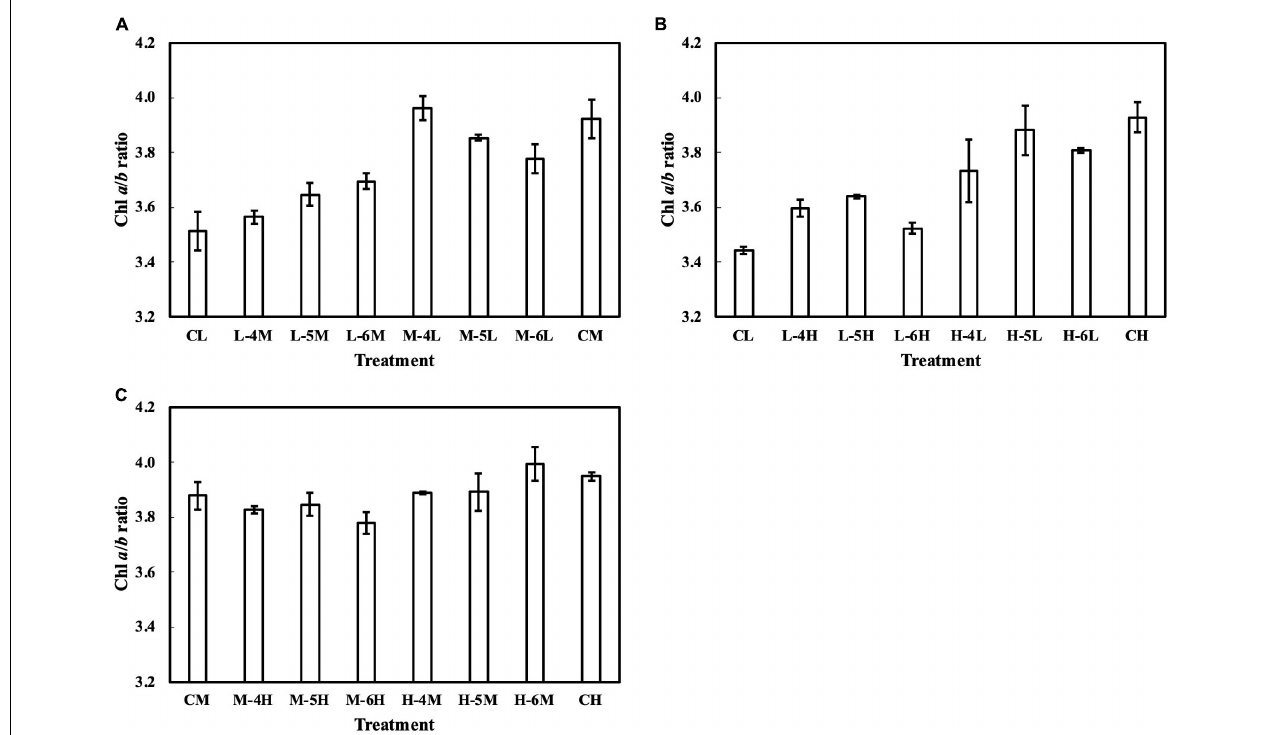
FIGURE 7 | Chl a / b ratio of leaves subjected to a PPFD for 1 day different from the basal PPFD in the other days. CL and CM: treatments with a constant PPFD of 100 and 400 µ mol m − 2 s − 1 , respectively. The experiment was divided into three groups (A–C) and conducted separately due to limited experimental capacity. Values were means ± standard errors ( n = 3). L–4M: treatment with a PPFD of 400 µ mol m − 2 s − 1 in the fourth day of treatment period and a basal PPFD of 100 µ mol m − 2 s − 1 in the other 5 days. See Supplementary Table 2 for details of